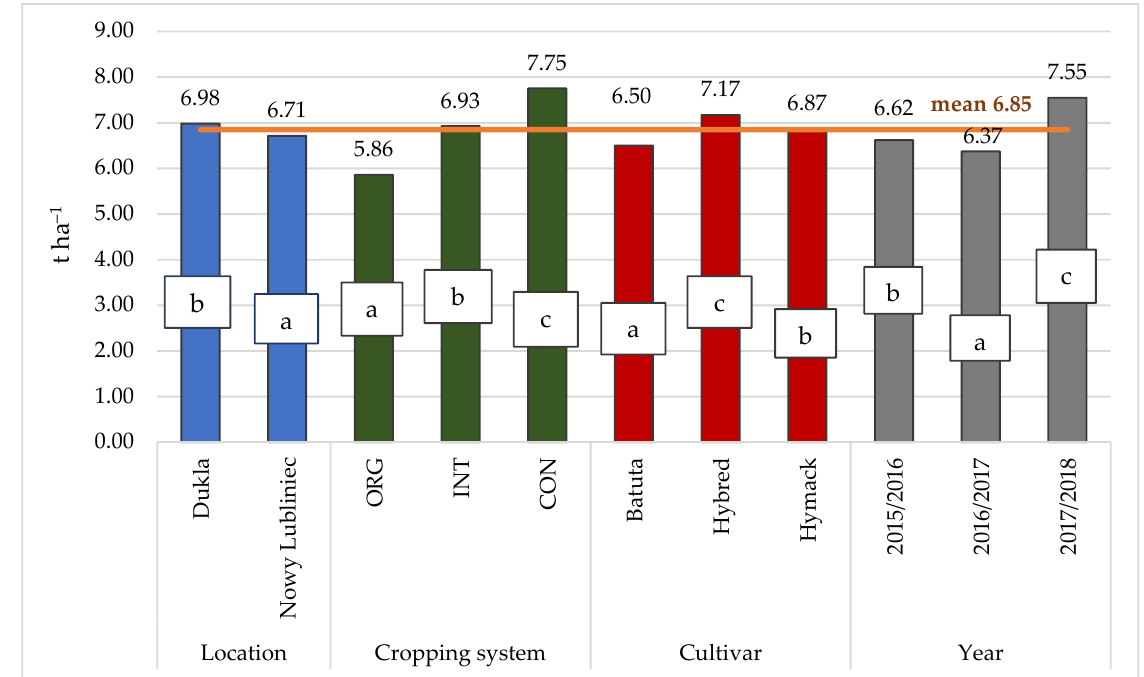
Figure 2. Wheat grain yield depends on location, cropping system, cultivar, and years of research. Di ff erent le tt ers show signi fi cant di ff erences between means (according to the Tukey test p < 0.05). ORG—organic system; INT—integrated system; CON—conventional system.